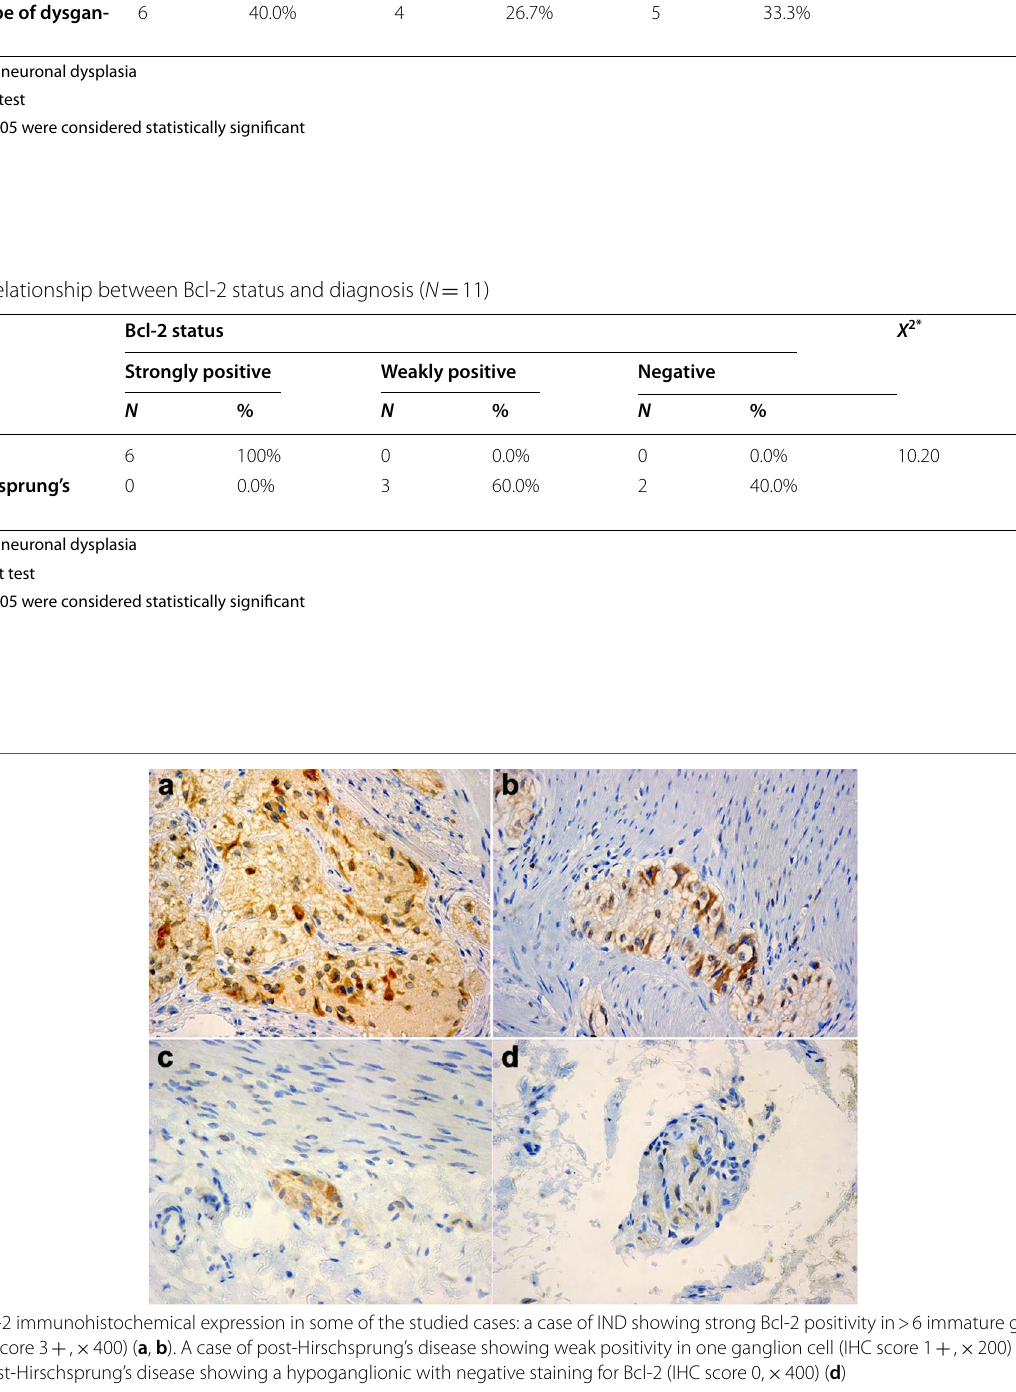
IND intestinal neuronal dysplasia * Fisher exact test